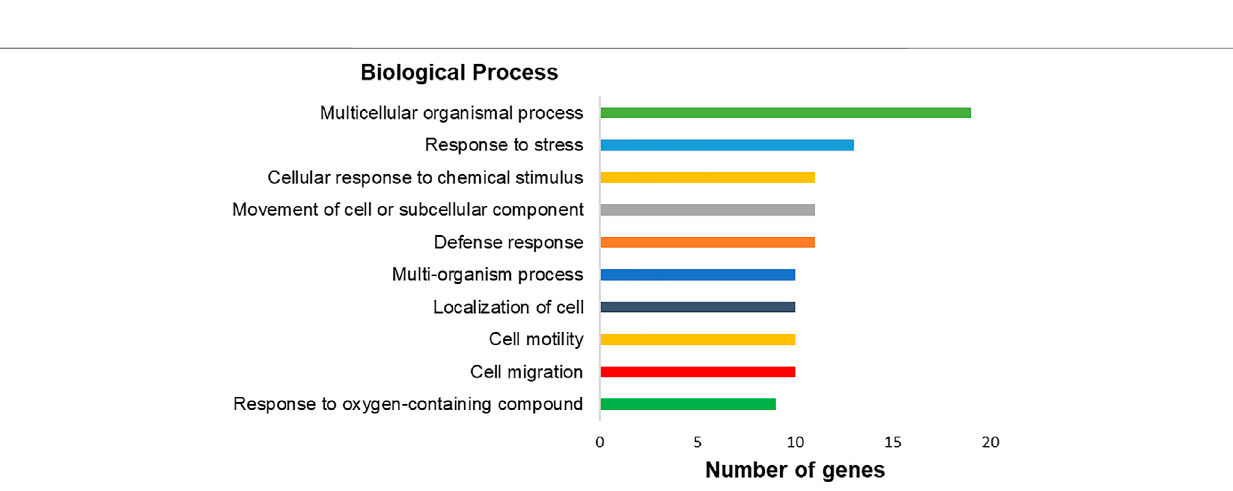
Frontiers in Molecular Biosciences |